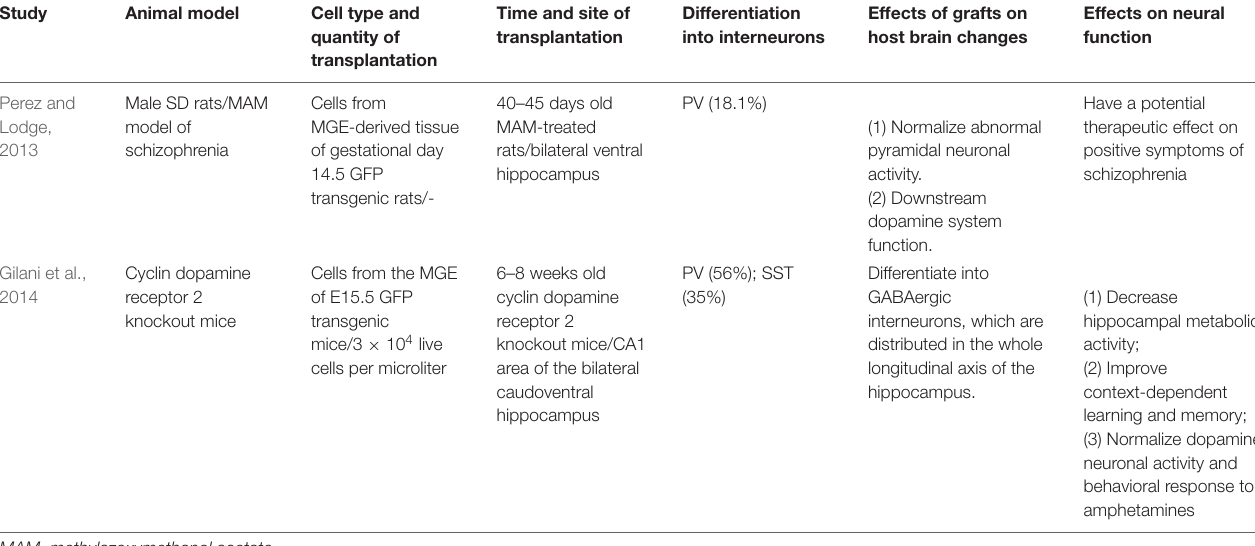
TABLE 2 | Medial ganglionic eminence cell transplantation for schizophrenia.